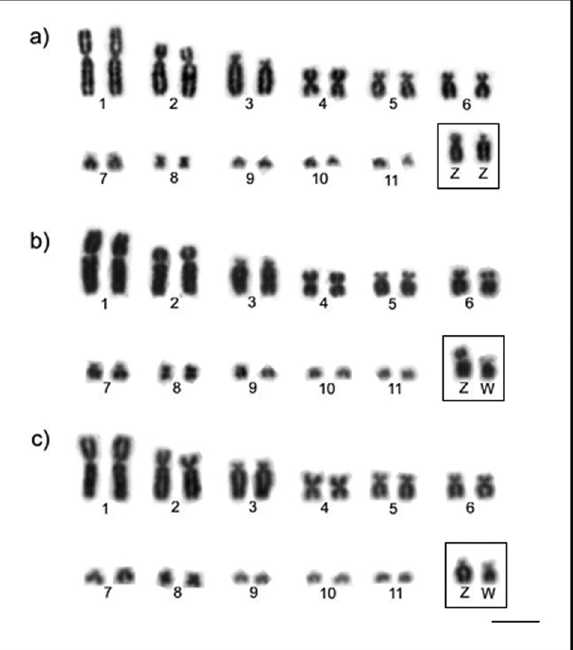
Figure 1 - Partial karyotype showing the largest autosomal pairs and ZW sex chromosomes of three Leptotila verreauxi individuals analyzed by conventional Giemsa-staining: (a) male with a submetacentric and acro- centric Z chromosomes; (b) female with submetacentric Z and W chromo- somes, (c) female with an acrocentric Z and a submetacentric W chromo- some. Sex chromosomes are boxed. Bar = 5 (cid:2)